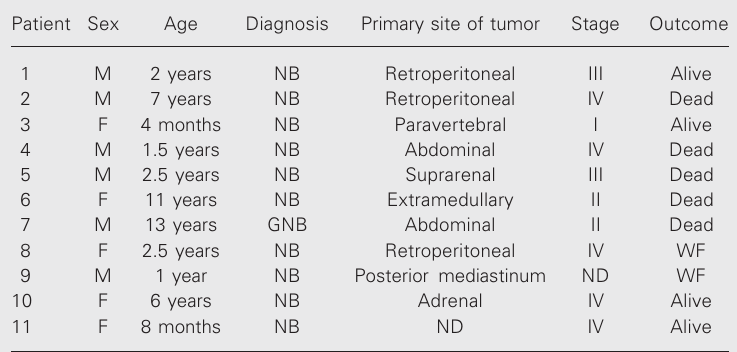
Table 1. Clinical pathological data and outcome of patients with neuroblastomas. Patient